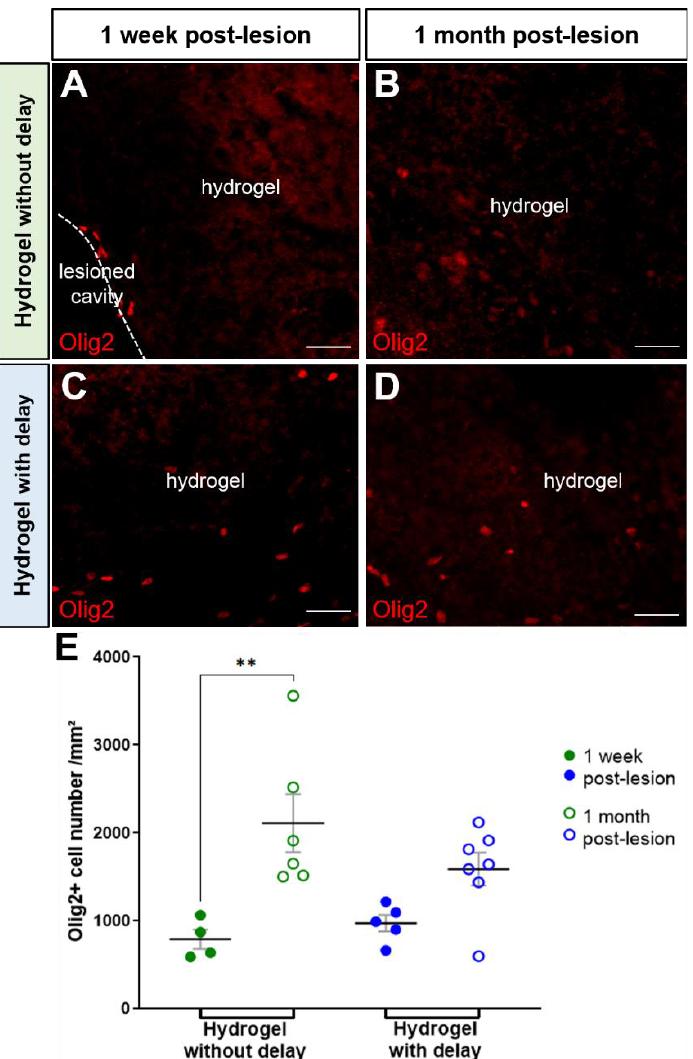
Figure 7. Oligodendrocytes into hydrogel. ( A – D ) Representative immunofluorescence staining of oligodendrocytes labeled with Olig2 (red) in no-delay ( A , B ) or delay implanted groups ( C , D ). Scale bar: 20 µ m. ( E ) Quantitative analysis of the oligodendrocyte number into the corpus callosum over time in lesioned (red) or implanted hydrogel in no-delay (green) or delay groups (blue). Two-way ANOVA ** p < 0.01.